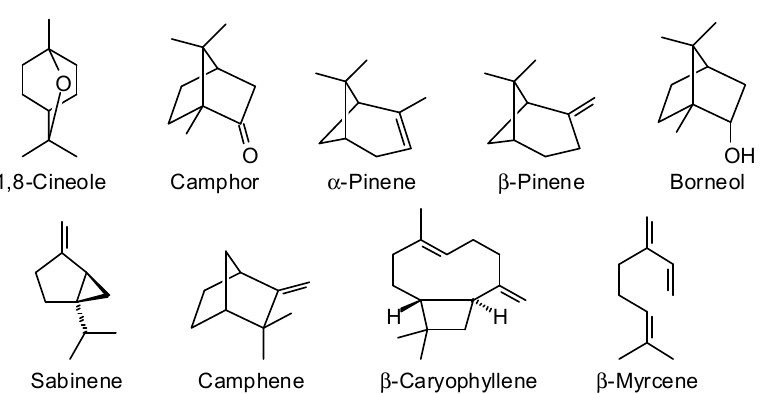
Figure 2. Chemical structures of common components found in six species of Conradina .